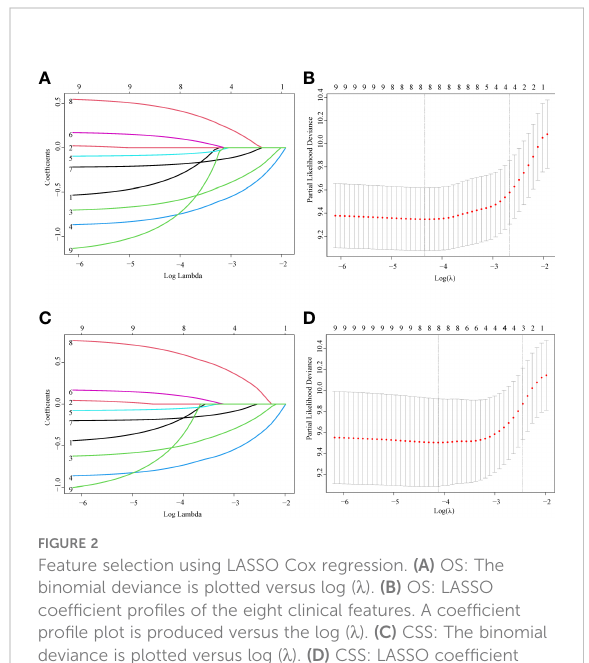
FIGURE 2 Feature selection using LASSO Cox regression. (A) OS: The binomial deviance is plotted versus log ( l ). (B) OS: LASSO coef fi cient pro fi les of the eight clinical features. A coef fi cient pro fi le plot is produced versus the log ( l ). (C) CSS: The binomial deviance is plotted versus log ( l ). (D) CSS: LASSO coef fi cient pro fi les of the eight clinical features. A coef fi cient pro fi le plot is produced versus the log ( l